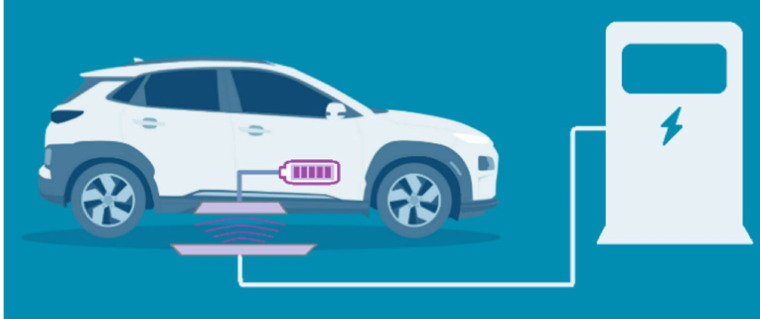
Figure 1. An imaginary diagram of WPT-based EV charging in DC microgrids.